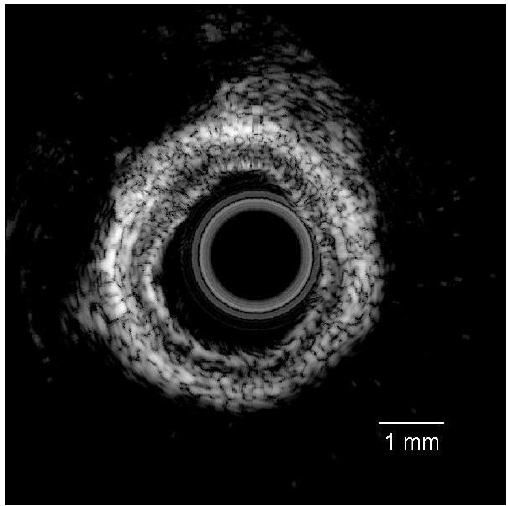
Figure 7. Ultrasonic image of the swine coronary artery captured by the IVUS transducer (with permission from [65]).